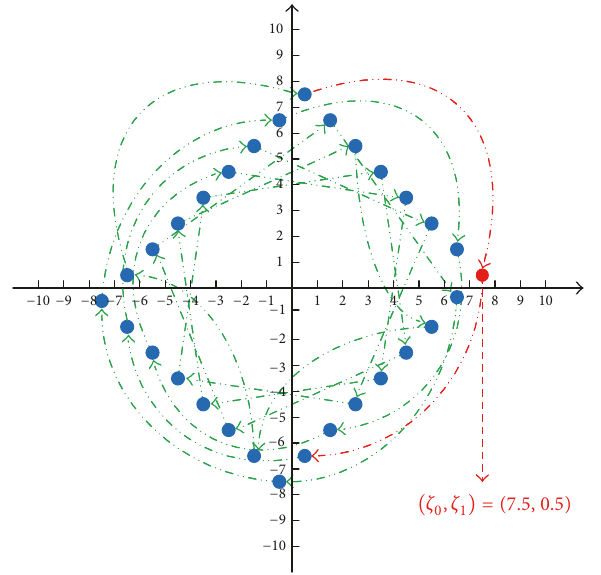
Figure 2: The orbit of 𝜉 with 𝜌 = 0